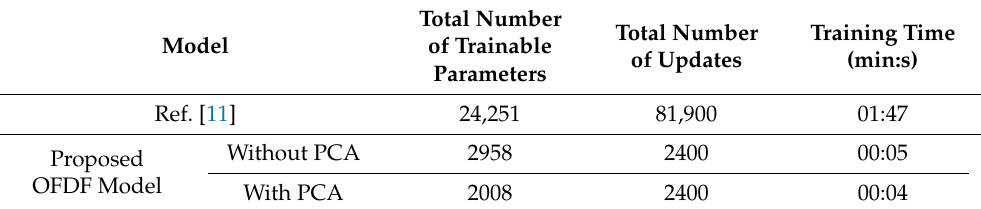
Table 4. A comparison of the total number of trainable parameters, total number of updates, and training time between the existing OFDF model [11], the proposed OFDF model without PCA, and the proposed OFDF model with PCA.